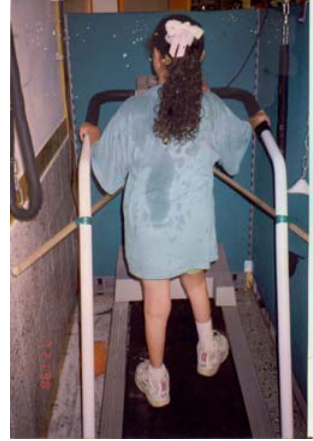
PICTURE 21 . A child with RS on the